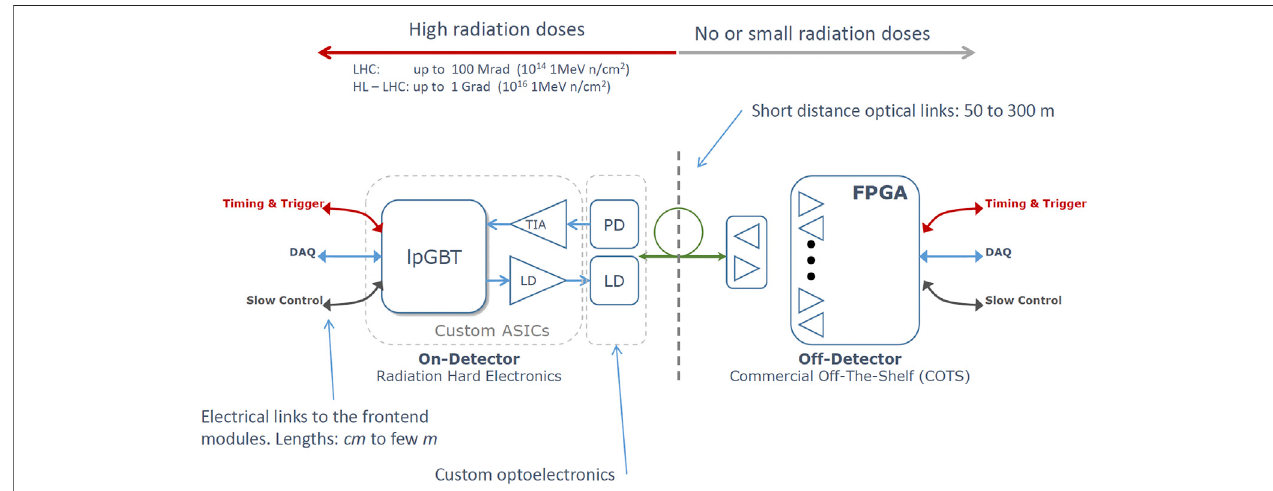
FIGURE 11 | Schematics of lpGBT application From [22].